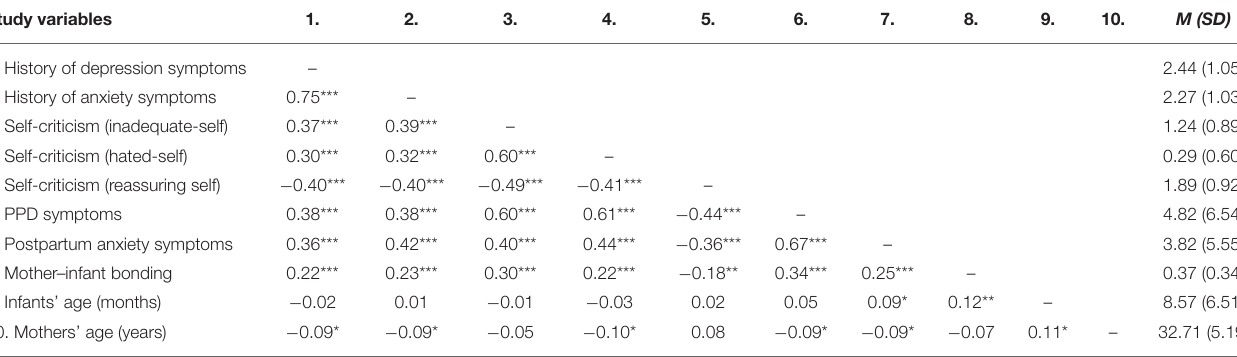
TABLE 2 | Correlations and descriptive statistics of history of depression and anxiety symptoms, self-criticism, postpartum negative affect, and mother–infant bonding. Study